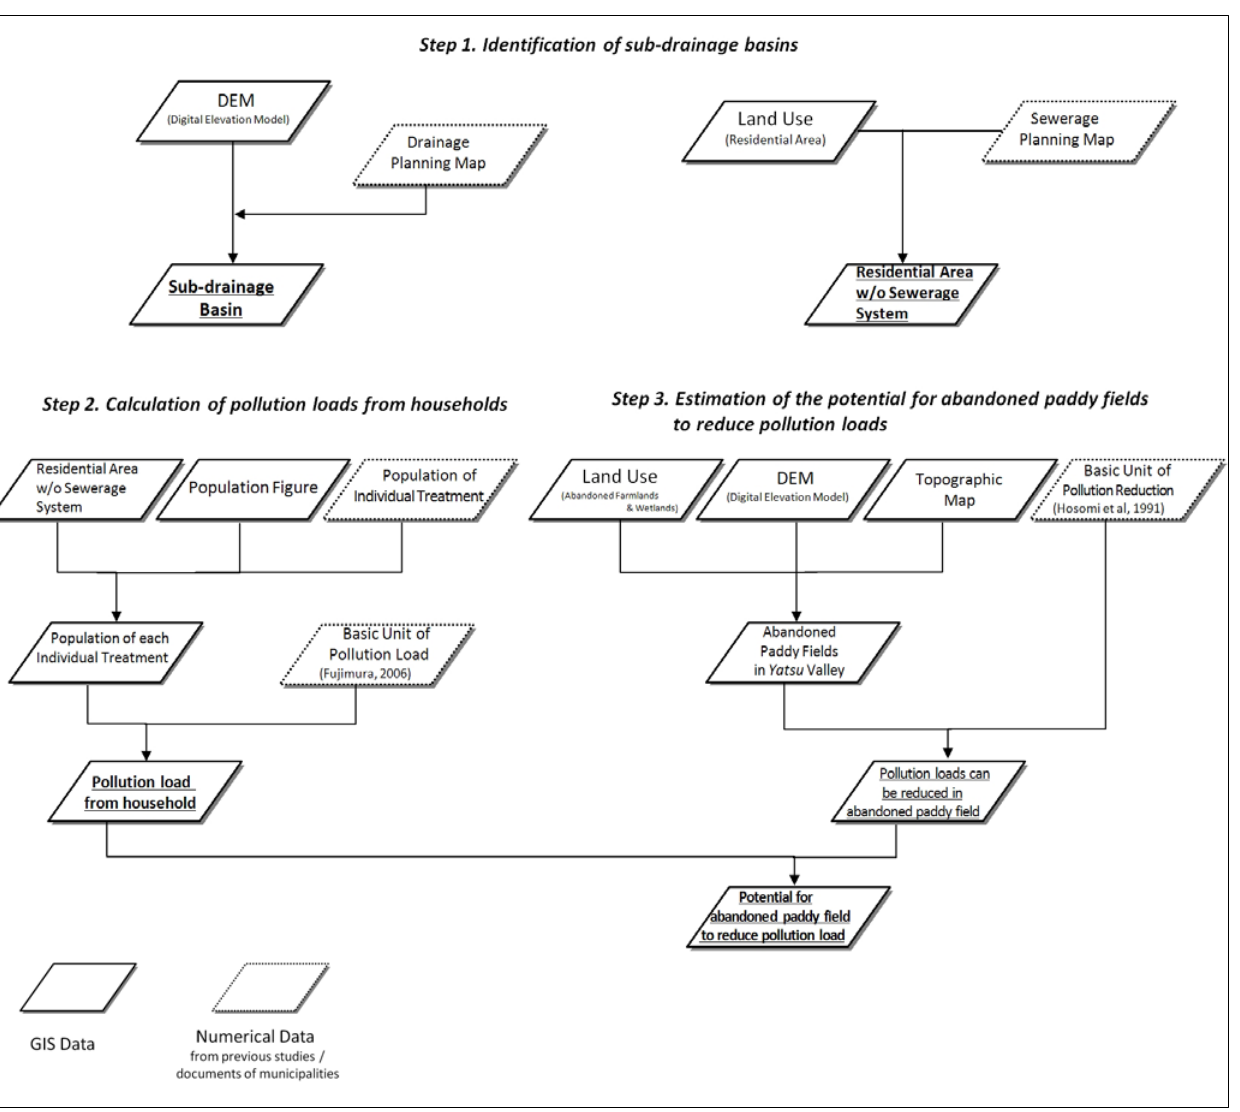
Figure 4. Diagram of the research methods and research